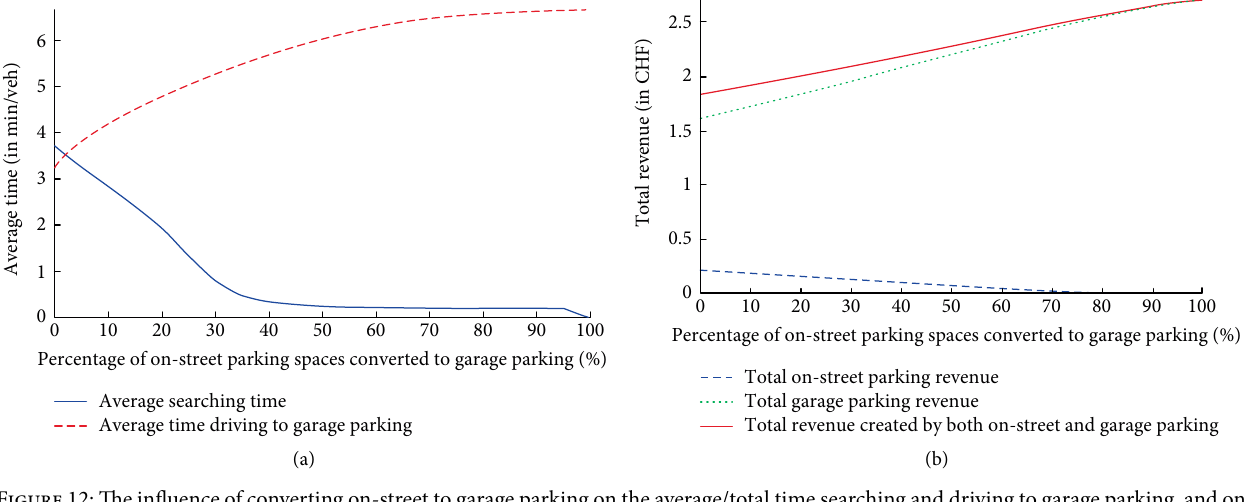
Figure 12: The influence of converting on-street to garage parking on the average/total time searching and driving to garage parking, and on the parking fee revenue in the network. (a) Impact on average time. (b) Impact on on-street and garage parking fee